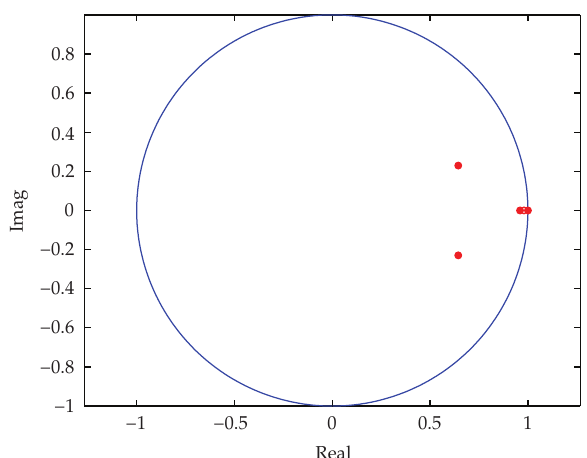
Figure 5: The eigenvalues of the stable limit cycle displayed on the unit circle.